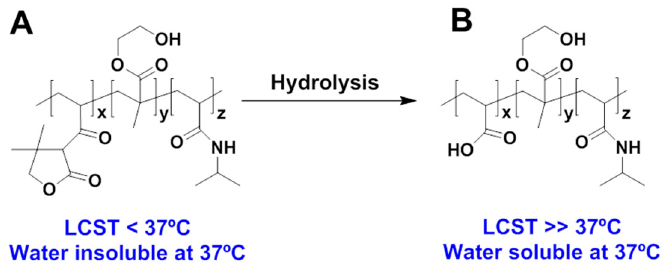
Figure 13. Chemical structures of P(NIPAAm- co -HEMA- co -DBA) triblock copolymer ( A ) before and ( B ) after hydrolysis of the hydrogel, as reported by Guan and co-workers [75].